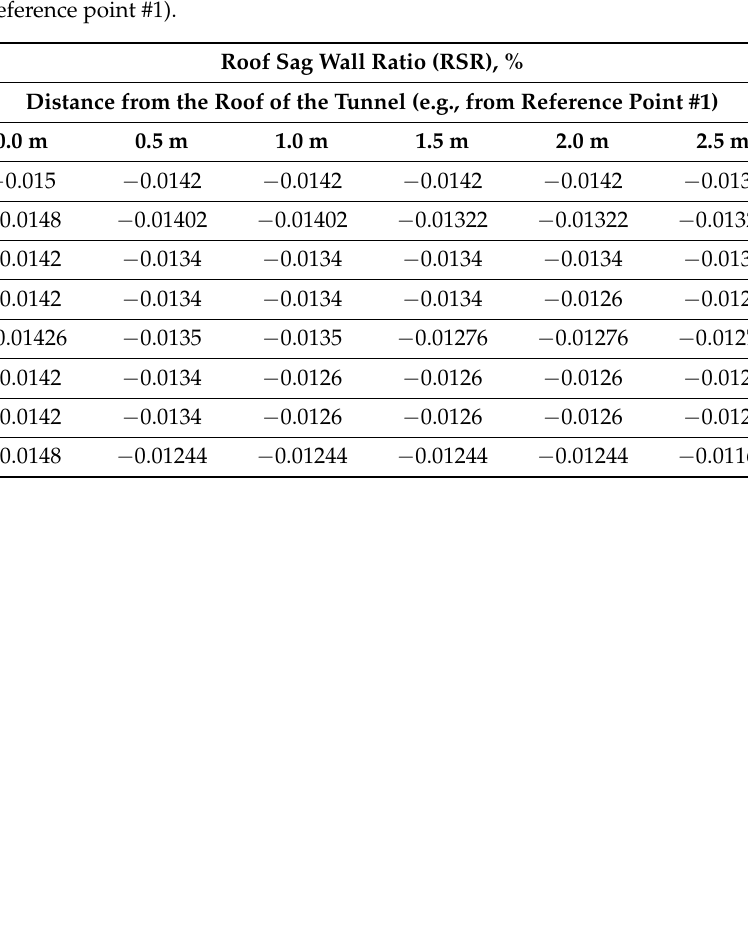
Figure 6. The ratio of roof sag and floor heave at various in situ stress ratios K monitored at different vertical displacements from tunnel boundary (e.g., point #1 and point #4), respectively. Table 5. Ratio of roof sag (RSR) at various in situ stresses and different distances from the roof of the tunnel (e.g., from reference point